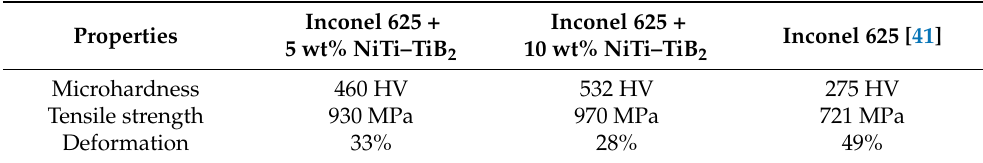
Table 3. Mechanical properties of materials Inconel 625 + 5 wt% NiTi-TiB2, Inconel 625 + 10 wt% NiTi-TiB 2 , and Inconel 625